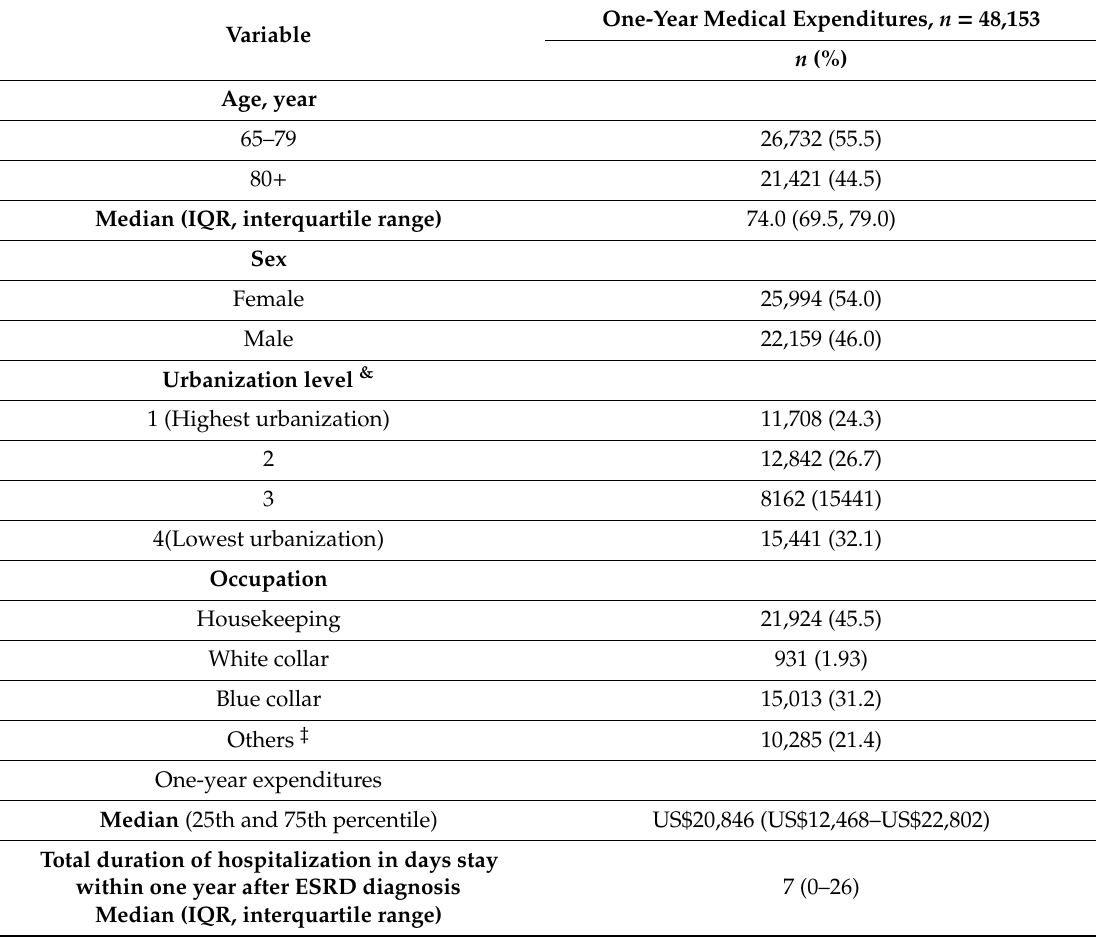
Table 1. Demographic characteristics and comorbidities by median medical expenditures in US$ within one year after end-stage renal disease (ESRD)